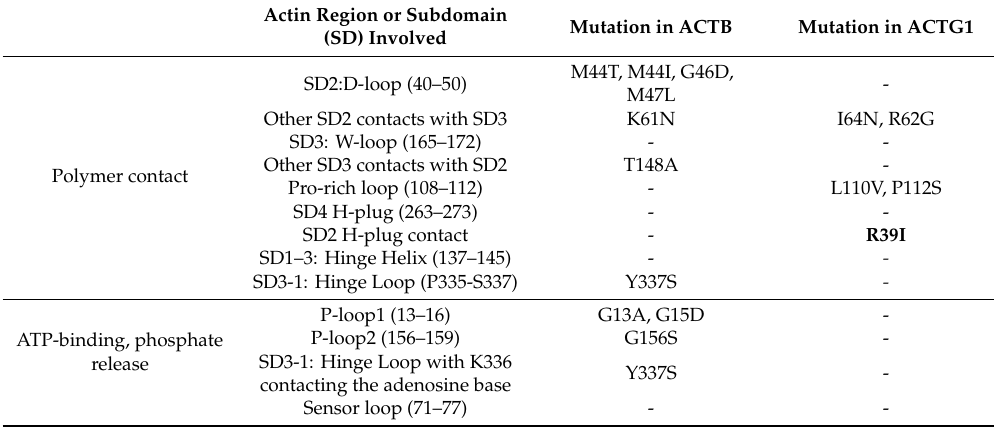
Table 4. Overview of cytoplasmic actin mutations in DLBCL (regular type) and multiple myeloma (bold) in regions involved in polymer formation, binding of ATP or phosphate release. – indicates no mutation is